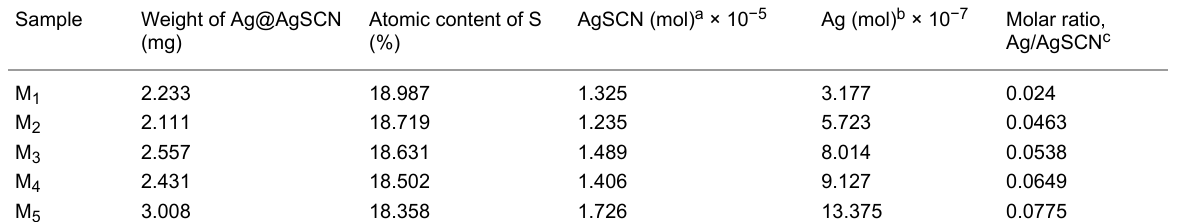
Table 1: Elemental content of the synthesized Ag@AgSCN samples with different reduction times. In all calculation process, the molar value of S was representative of AgSCN. Sample